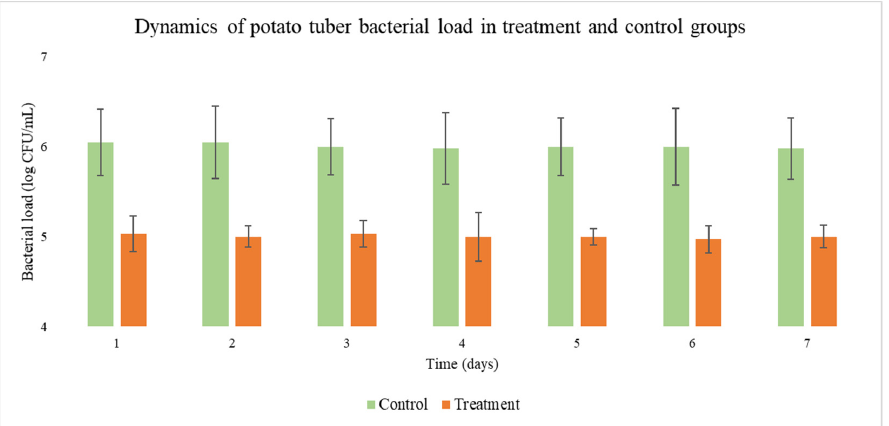
Figure 3. Reduction in the population of pectolytic bacteria on the surface of potato tubers after phage application. Tubers treated with phage cocktail compared to treatment with water. Error bars indicate standard deviation (control); p < 0.05 for averaged values comparison across the whole experiment.